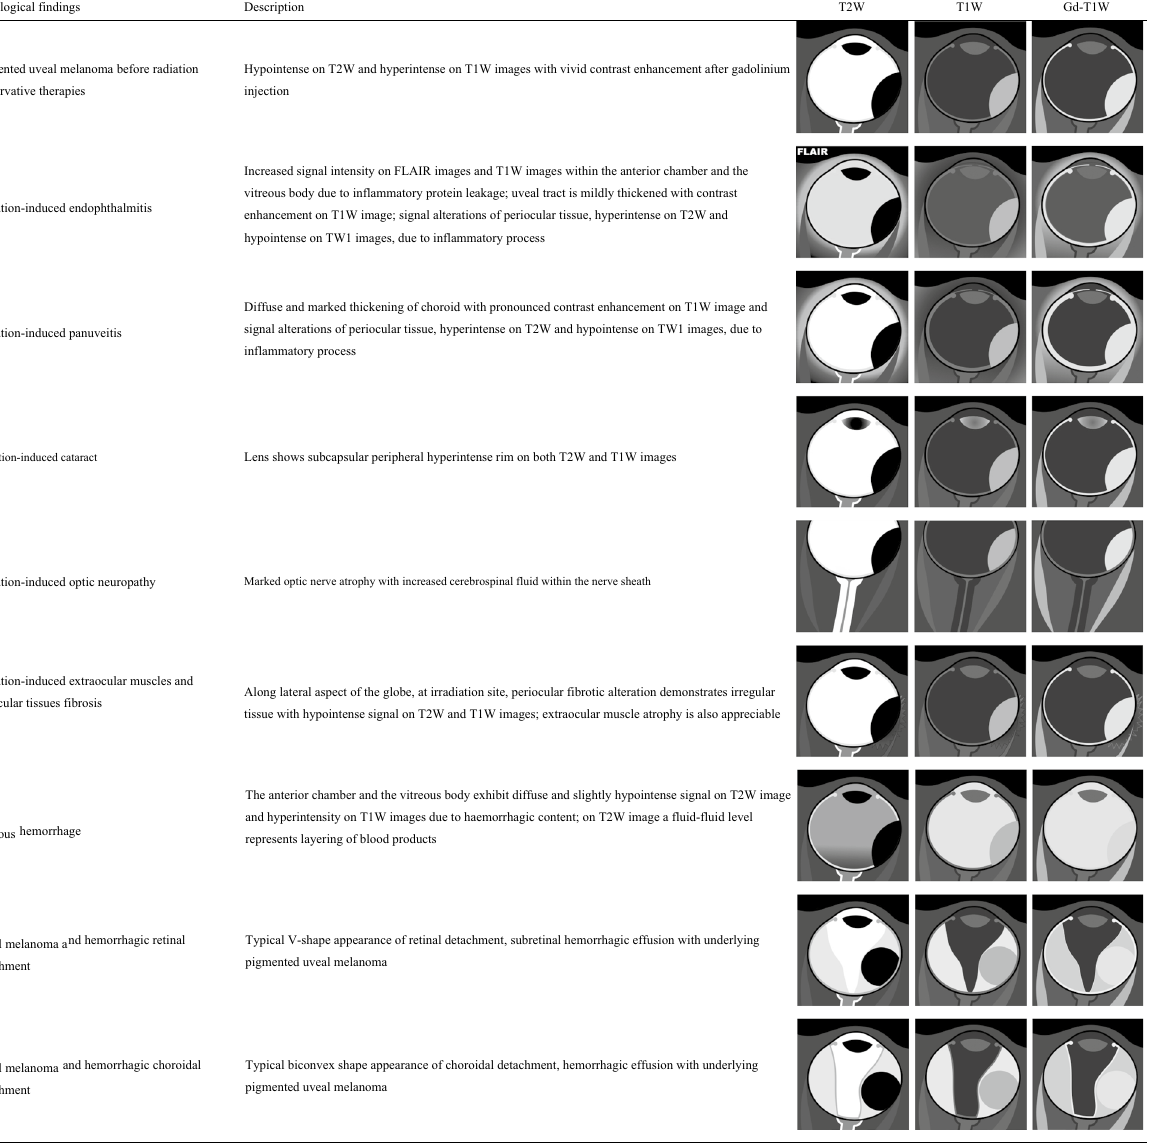
Table 2 Chart summarizing MR imaging features of radiotherapy-related ocular and periocular complications of uveal melanoma